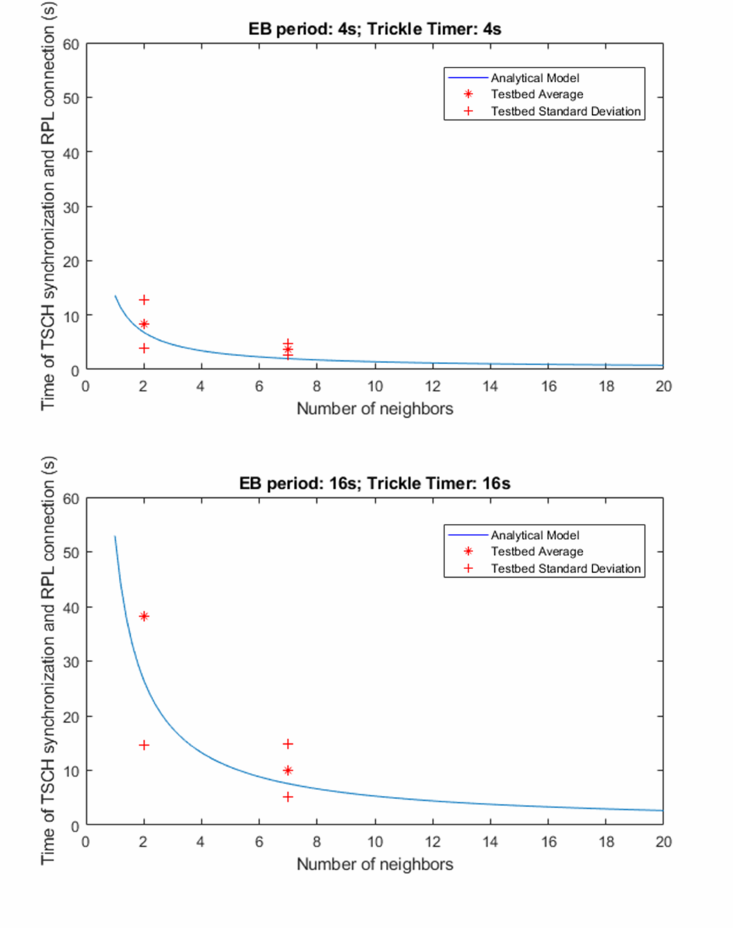
Figure 7. Testbed results—time of synchronization and RPL